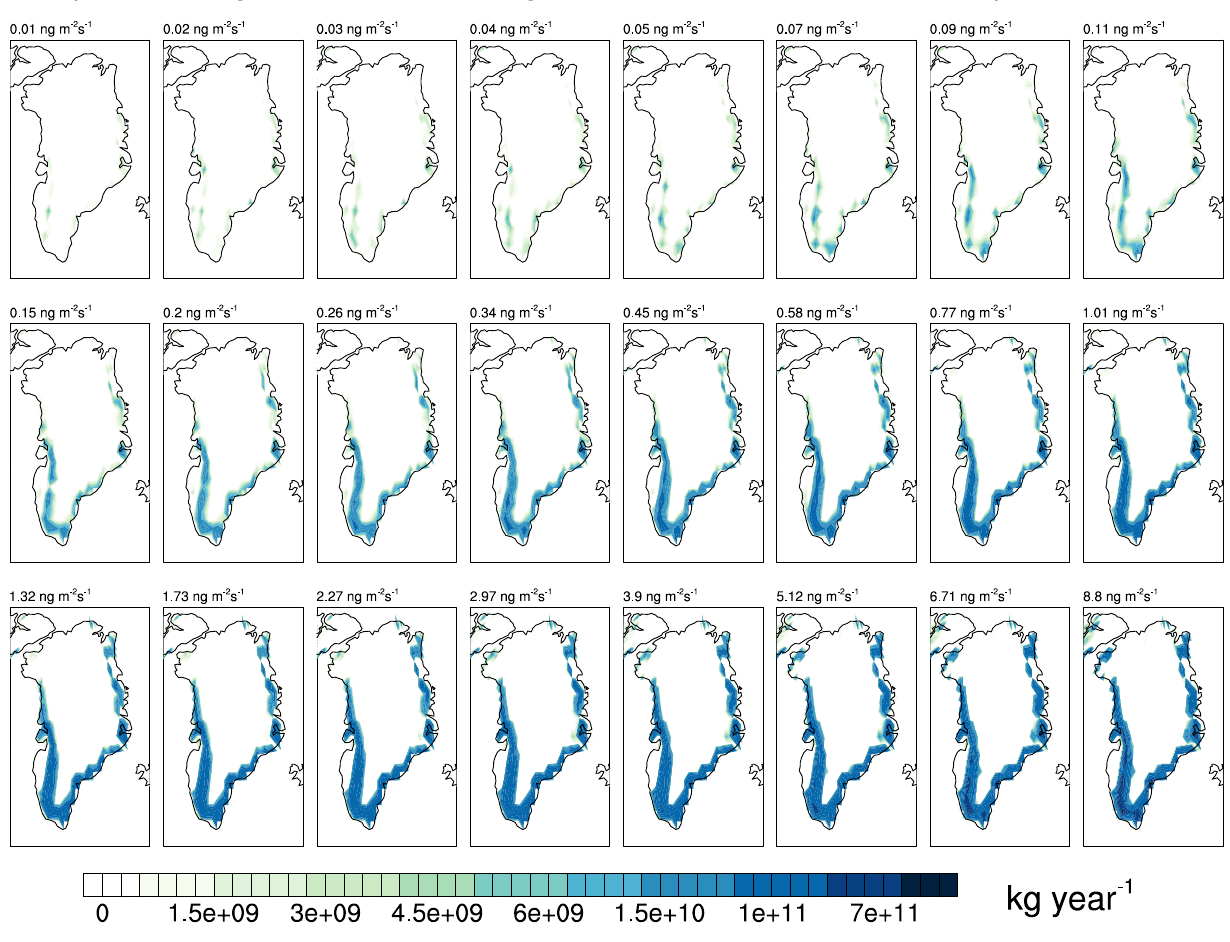
Figure 12. Same as Fig. 11, but resulting from different dry deposition fluxes of BC in June.